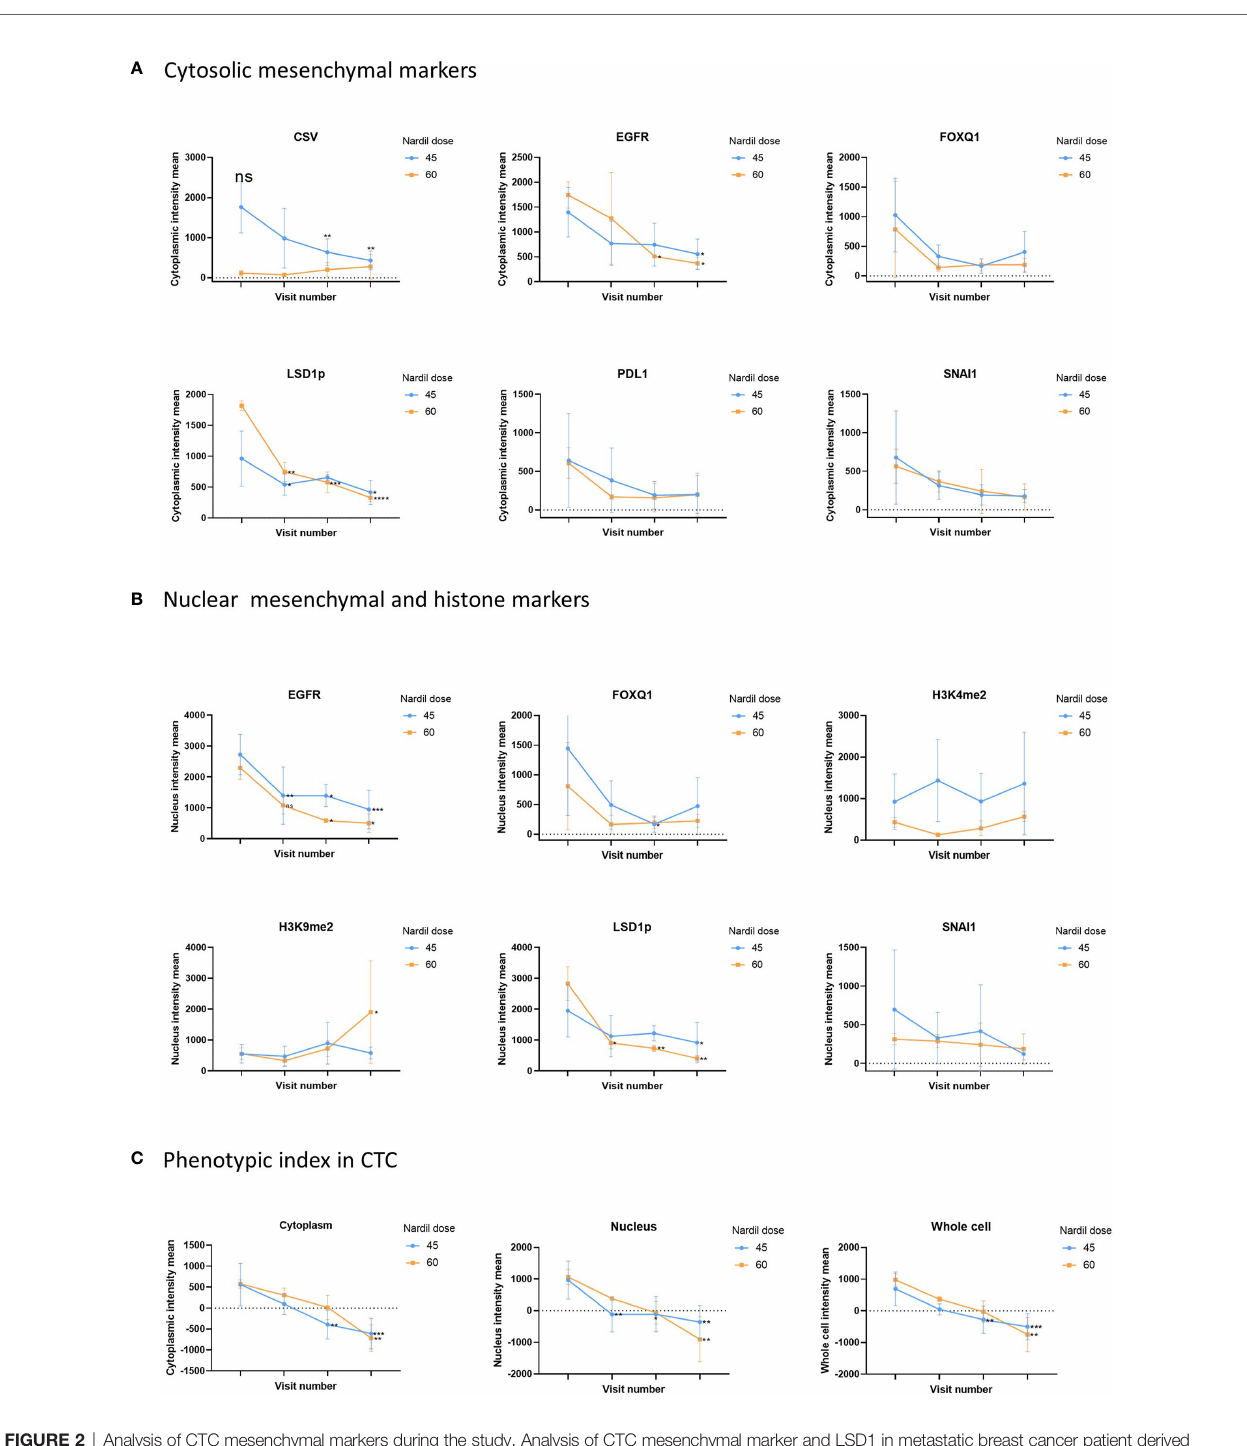
FIGURE 2 | Analysis of CTC mesenchymal markers during the study. Analysis of CTC mesenchymal marker and LSD1 in metastatic breast cancer patient derived CTCs. Figure shows differential changes between phenelzine 45mg (blue) and 60mg (Red). CTCs were isolated at baseline, cycle 1 (Day 29), 2 (Day 57) or cycle 3 (Day 85 end of study). (A) Shows changes in mean cytoplasmic intensity of CSV, LSD1s111p (LSD1p), EGFR, FOXQ1, PD-L1 or SNAI1 during the course of trial. (B) Shows changes in nuclear intensity of H3K9me2, H3K4me2, LSD1s111p, EGFR, FOX1Q, or SNAI1. (C) Phenotypic index, measuring the phenotypic change in the patients CTCs was calculated as described in the methods for the cytoplasmic, nuclear and whole cell scores. This score was then plotted for cycle 1 to 3 compared to baseline readings. Signi fi cant differences were determined with a two-way ANOVA with multiple comparisons to baseline and are indicated, *<0.05, **<0.01, ***<0.001, ****<0.001, ns, not signi fi